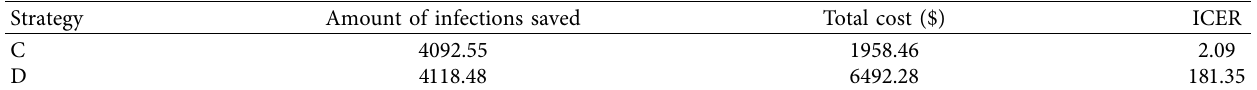
Table 8: Amount of the total infection averted and total cost used with